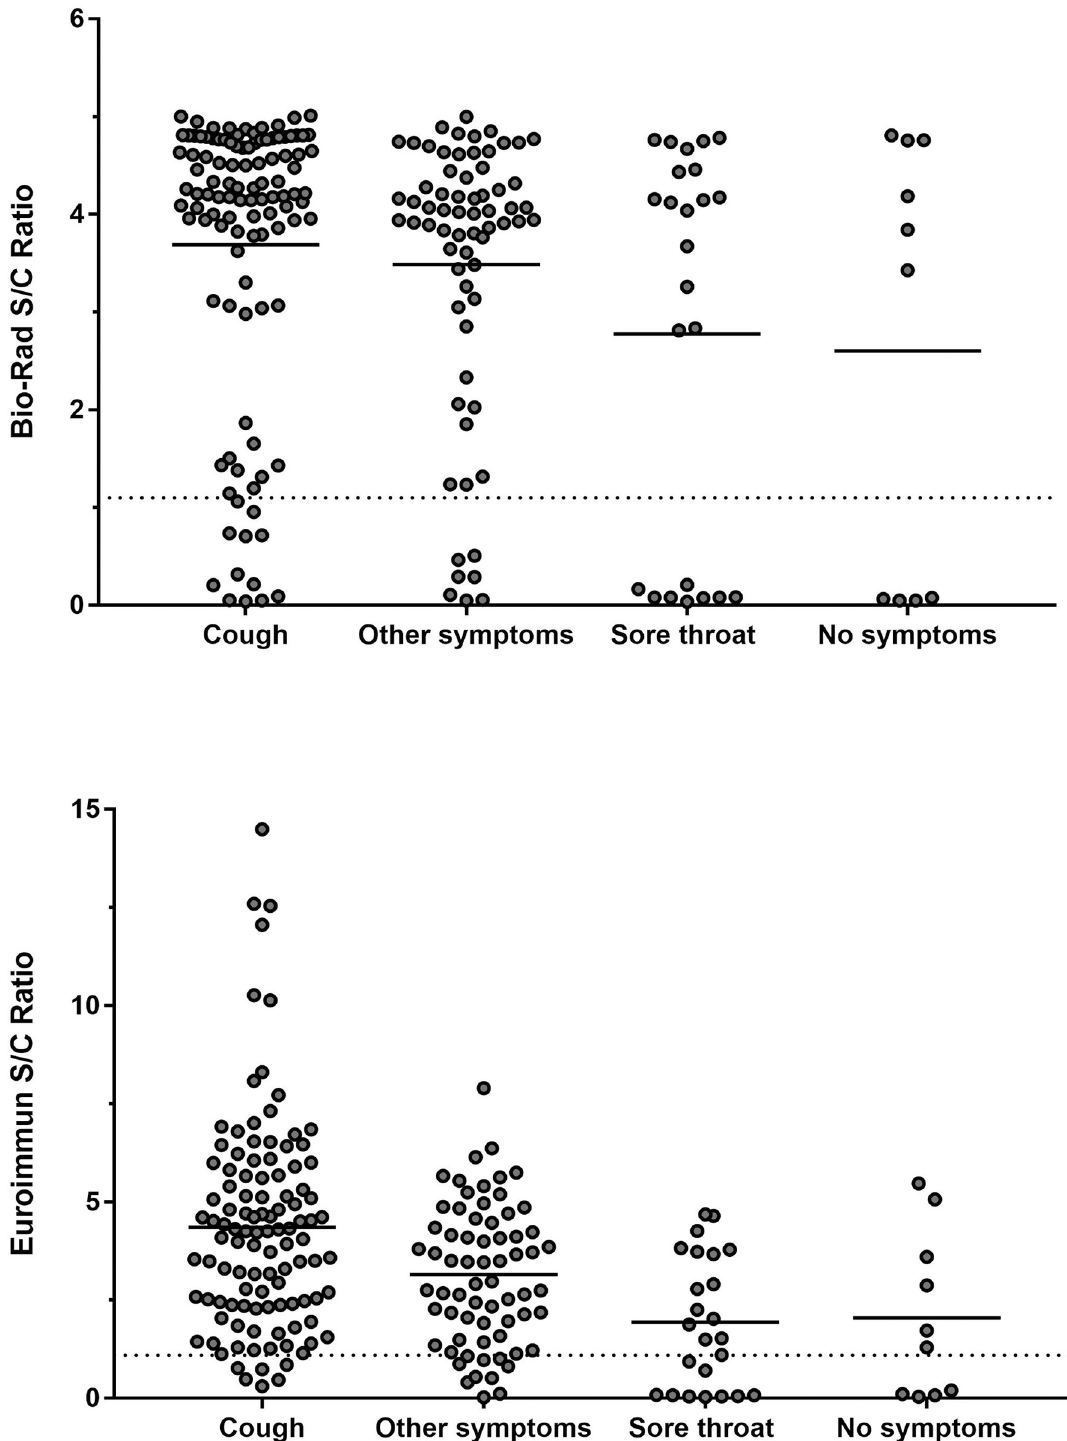
Fig 3. Antibody reactivity to nucleocapsid protein as measured by Bio-Rad ELISA and S1 protein as measured by Euroimmun ELISA stratified by symptom category. Solid horizontal lines represent the mean S/C ratio for the indicated symptom group. Dashed horizontal line represents the positive result threshold for the indicated